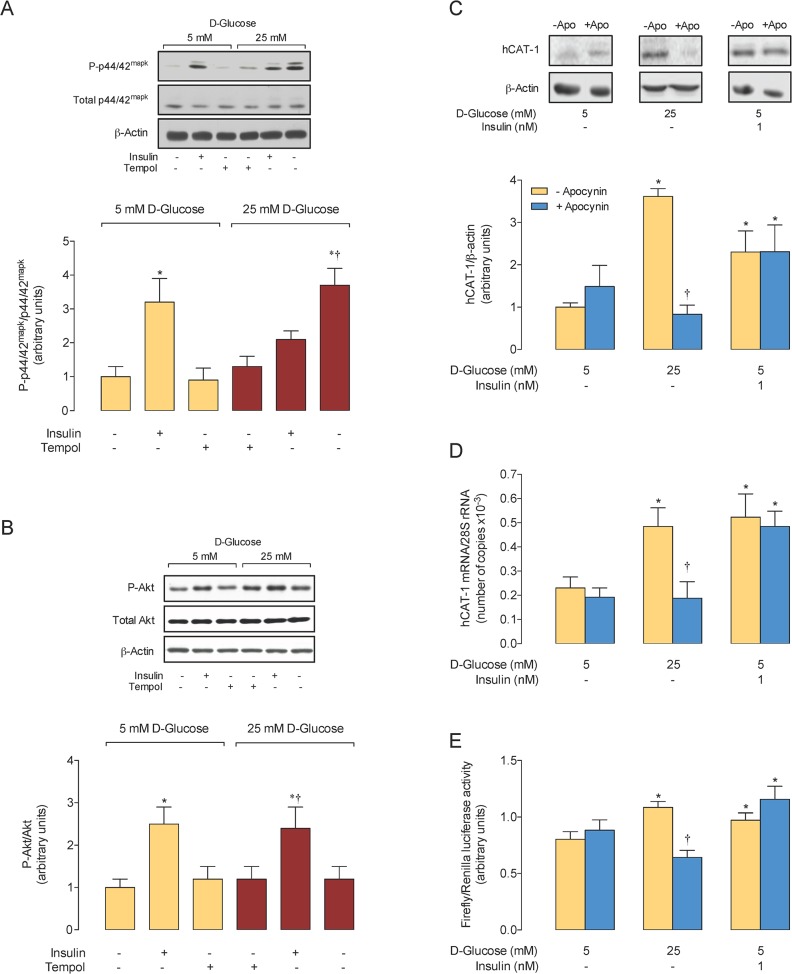
Apocynin blocks high D-glucose, but not insulin-increase in hCAT-1 expression and SLC7A1 promoter activity.A, Western blot for total (Total p42/44mapk) or phosphorylated p42/44mapk (P~p42/44mapk) protein abundance in HUVECs incubated (24 hours) in 5 or 25 mmol/L D-glucose in the absence (–) or presence (+) of 1 nmol/L insulin or 1 mmol/L tempol. β -Actin is internal reference. Lower panel: P~p42/44mapk/Total p42/44mapk ratio densitometries normalized to 1 in 5 mmol/L D-glucose in the absence of insulin or tempol. B, Western blot for total (Total Akt) or phosphorylated Akt (P~Akt) protein abundance as in A. Lower panel: P~Akt/Total Akt ratio densitometries normalized to 1 in 5 mmol/L D-glucose in the absence of insulin or tempol. C, Western blot for hCAT-1 protein abundance in the absence (–) or presence of insulin, without (–Apo) (Control) or with (+Apo) 100 μmol/L apocynin. Lower panel: hCAT-1/β-actin ratio densitometries normalized to 1 in 5 mmol/L D-glucose in the absence of insulin or apocynin. Bars are cells without (–Apocynin) or with 100 μmol/L apocynin (+Apocynin). D, Number of copies of hCAT-1 mRNA and 28S rRNA (internal reference) in cells as in C. E, Luciferase reporter construct activity for cells transfected with a truncated SLC7A1 promoter (-650 bp (pGL3-hCAT-1-650) from ATG) as in C. In A–B, *P<0.04 versus all other corresponding values in 5 or 25 mmol/L D-glucose. †P<0.05 versus 5 mmol/L D-glucose in the absence of insulin and tempol. In C–E, *P<0.05 versus corresponding values in the absence of insulin and apocynin. †P<0.05 versus corresponding value in 25 mmol/L D-glucose in the absence of apocynin. Values are mean ± S.E.M. (n = 5–6).